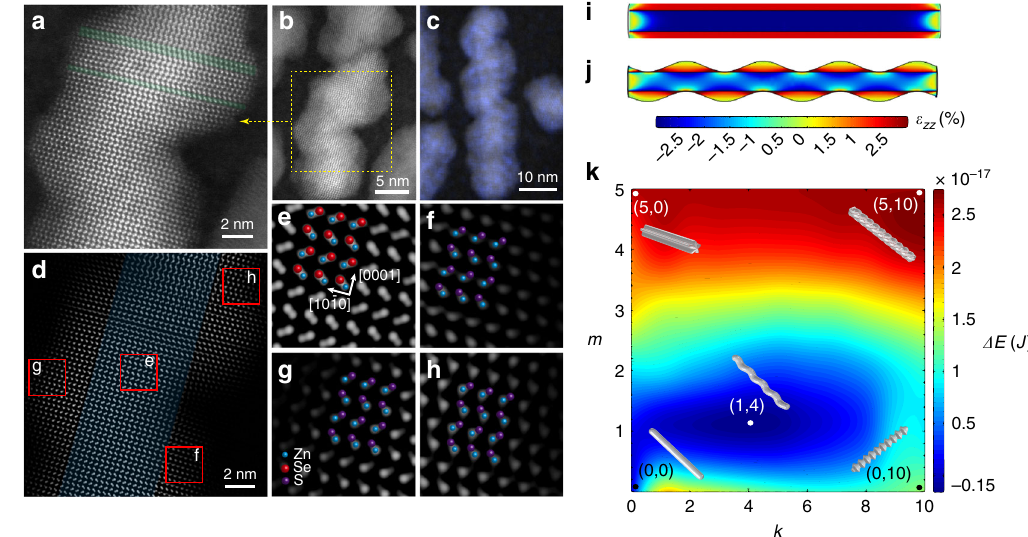
Fig. 3 Helical-shell growth of ZnS on ZnSe nanorods. a , b High-resolution HAADF STEM images of ZnSe/ZnS core/helical-shell nanorods. Stacking faults are marked in green in ( a ) and are not correlated with the helical pitch. c HAADF STEM image of ZnSe/ZnS core/helical-shell nanorods overlaid with Zn elemental mapping. d Inverse fast Fourier transform (IFFT) fi ltered image corresponding to a . e – h Magni fi ed images of the areas indicated in d . Zn atoms are marked in blue, Se atoms in red and S atoms in purple. Coherent growth of the lattice is identi fi ed. i The calculated elastic strain tensor ε zz of ZnSe nanorod with a fl at ZnS shell. j The calculated elastic strain tensor ε zz of ZnSe nanorod with a helical ZnS shell. k Mapping of energy differences Δ E between the total surface and strain energy for different shell morphologies compared to the fl at shell with the same shell volume corresponding to four monolayers. The different morphologies are represented by the number of islands along the perimeter ( m ) and the number of islands along the rod length ( k ). Several models with different m and k are illustrated to show the energy difference. The minimal energy is obtained for the helical-shell